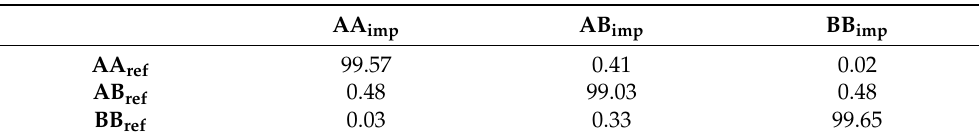
Table 1. Concordance rate in percentage between imputed and real genotypes for imputation from 50K to 700K (991 700K